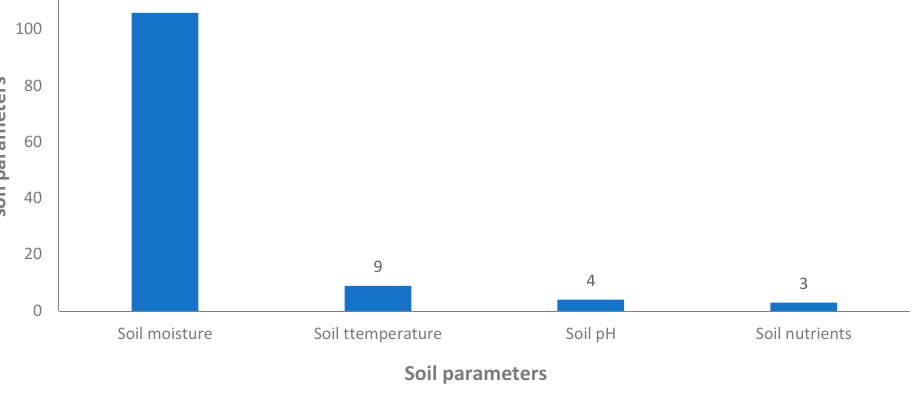
Figure 12. Information about the used moisture sensors in all the evaluated papers.